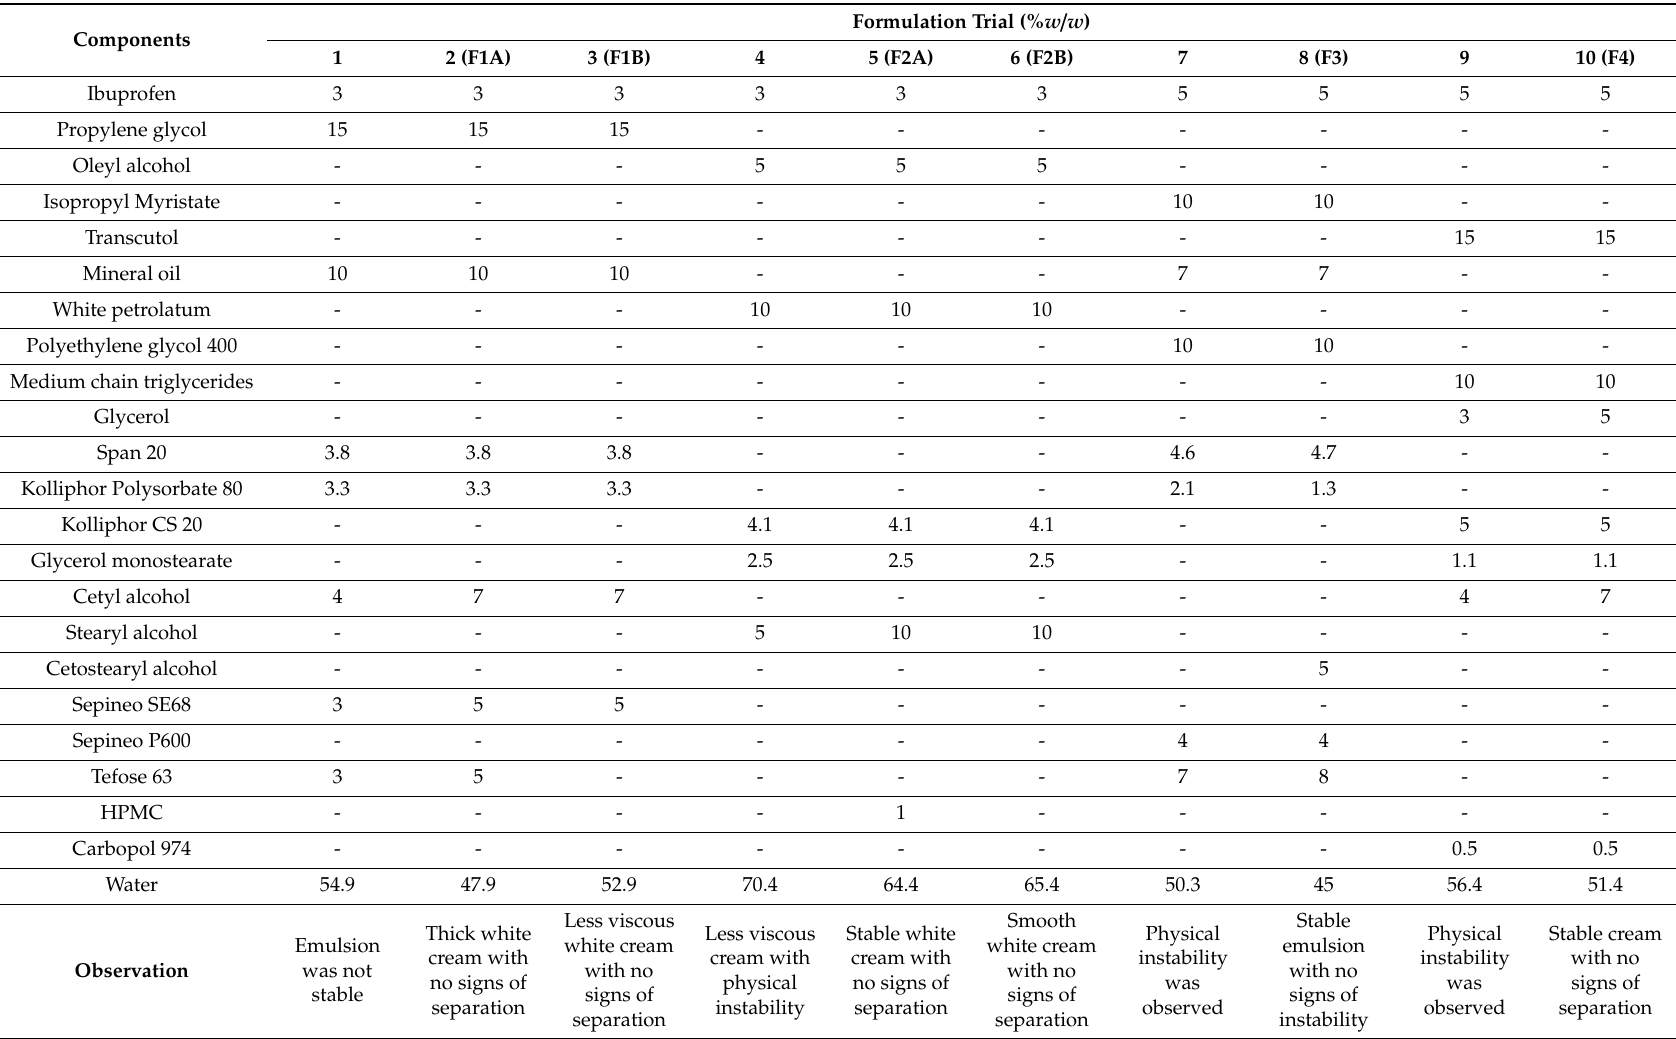
Table A1. Optimization of cream